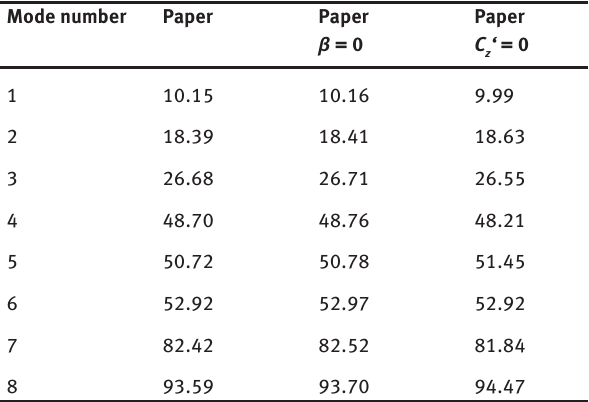
Table 3: Eigenfrequencies for different models in case of clamped- clamped support (C-C) [Hz].